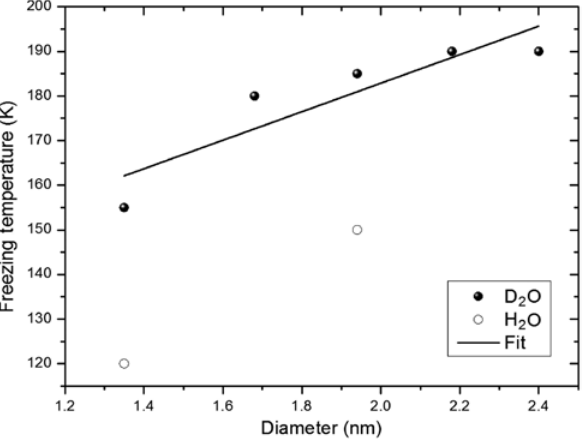
O and H O in SWCNTs 2 2